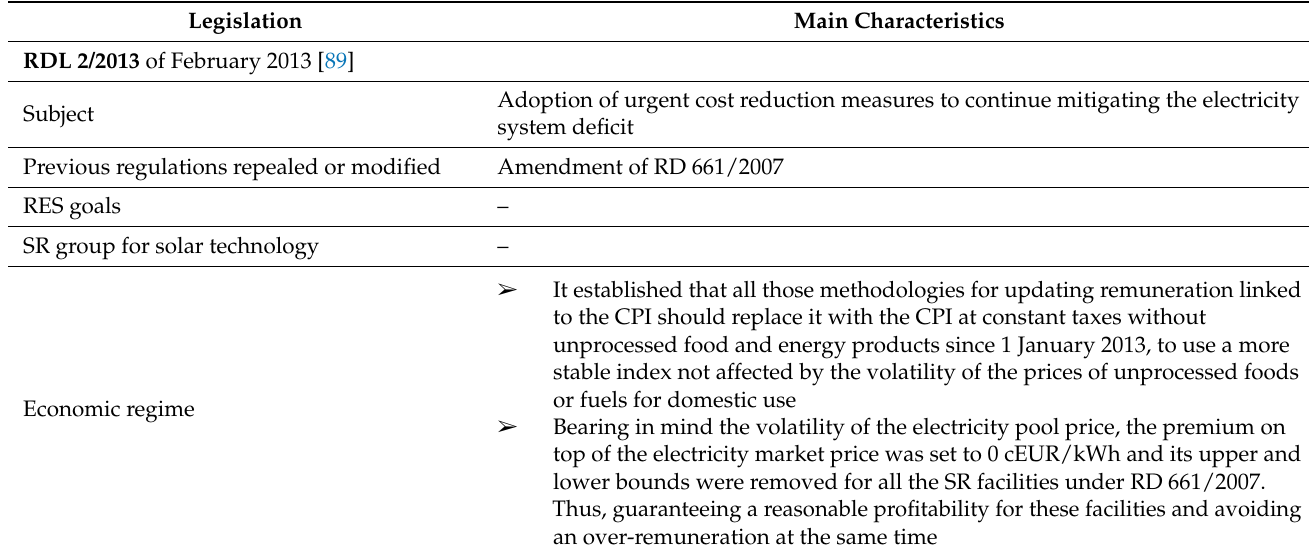
Table 10. Major characteristics of the different regulatory frameworks in force for solar power